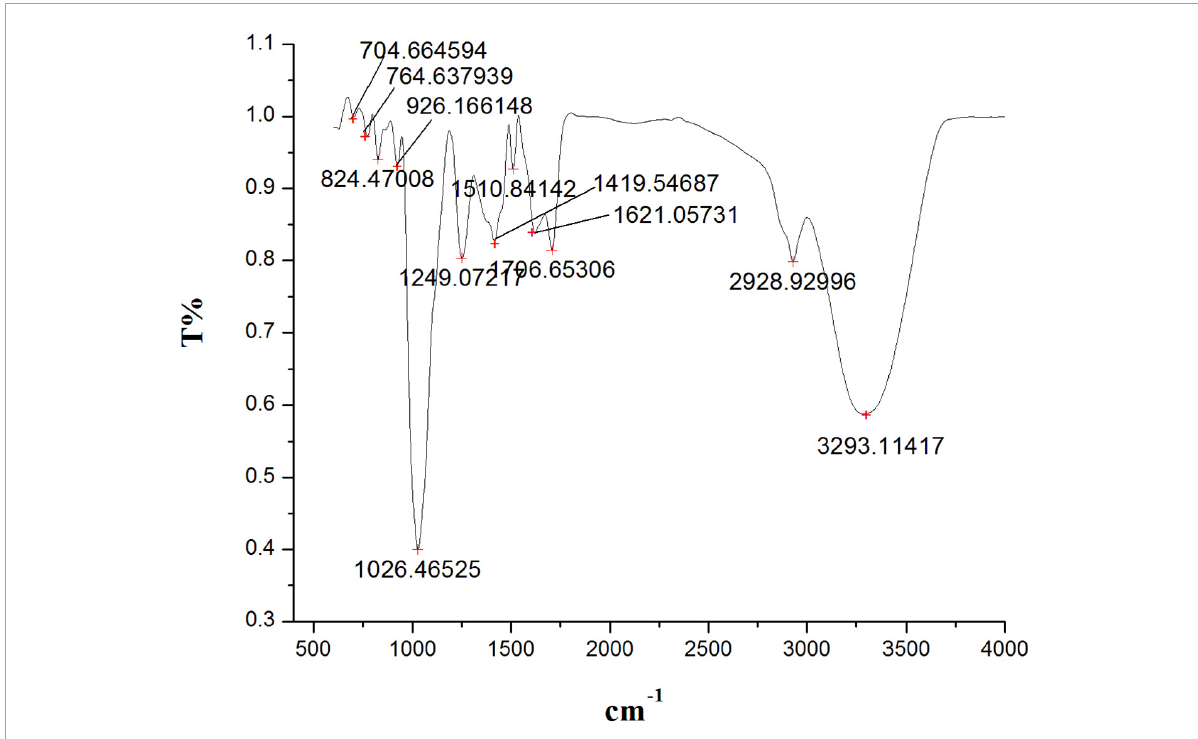
FIGURE4 Fourier transform infrared spectrometer (FTIR) spectrum from methanolic root extract of Skimmia anquetilia